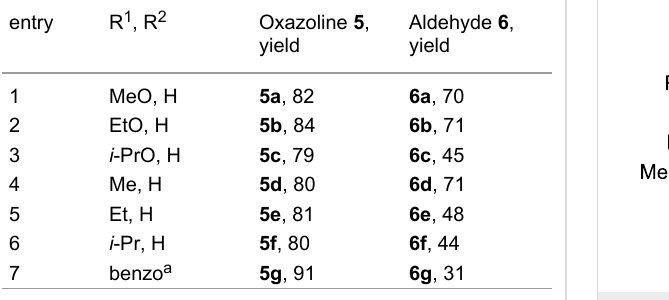
Scheme 1: Synthesis of racemic aldehydes.